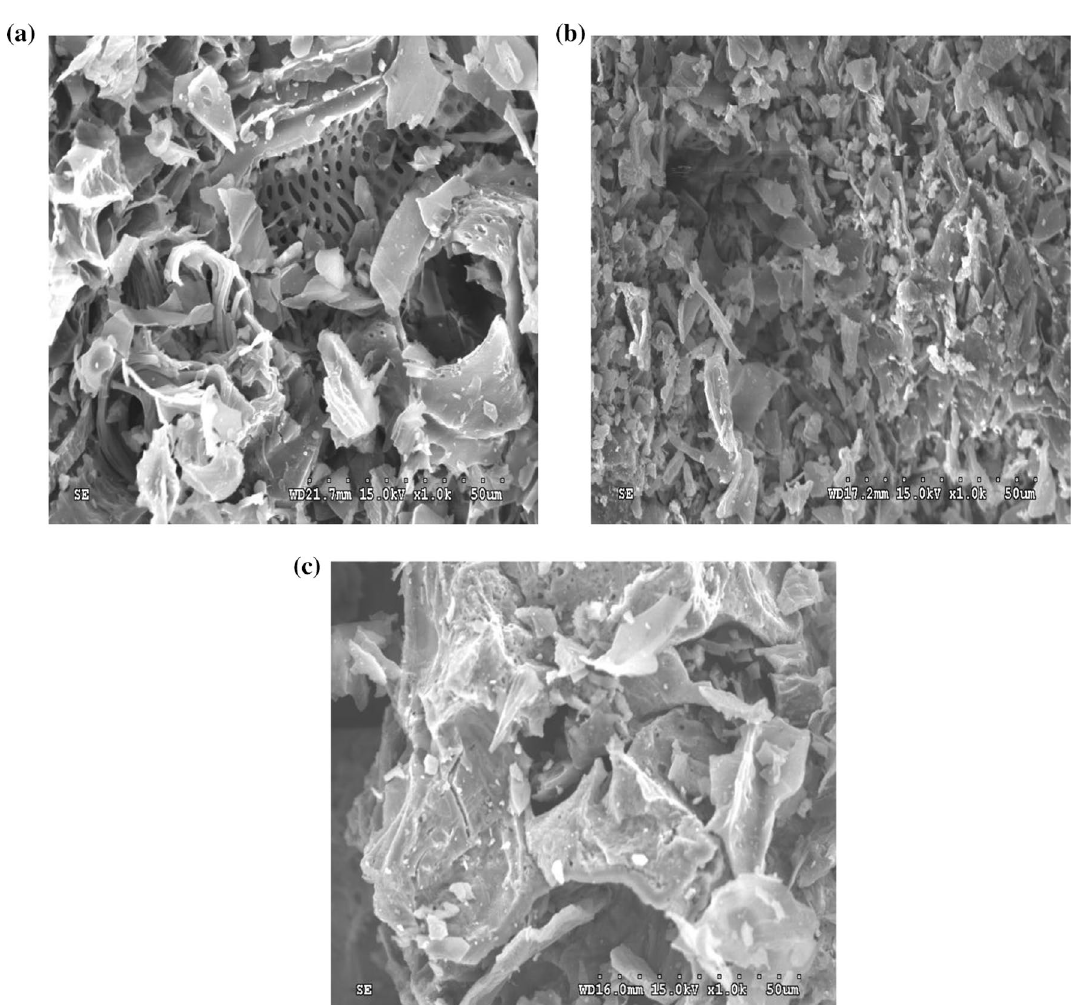
Fig. 2 SEM image of a ACWI b IIAC before adsorption c IIAC after